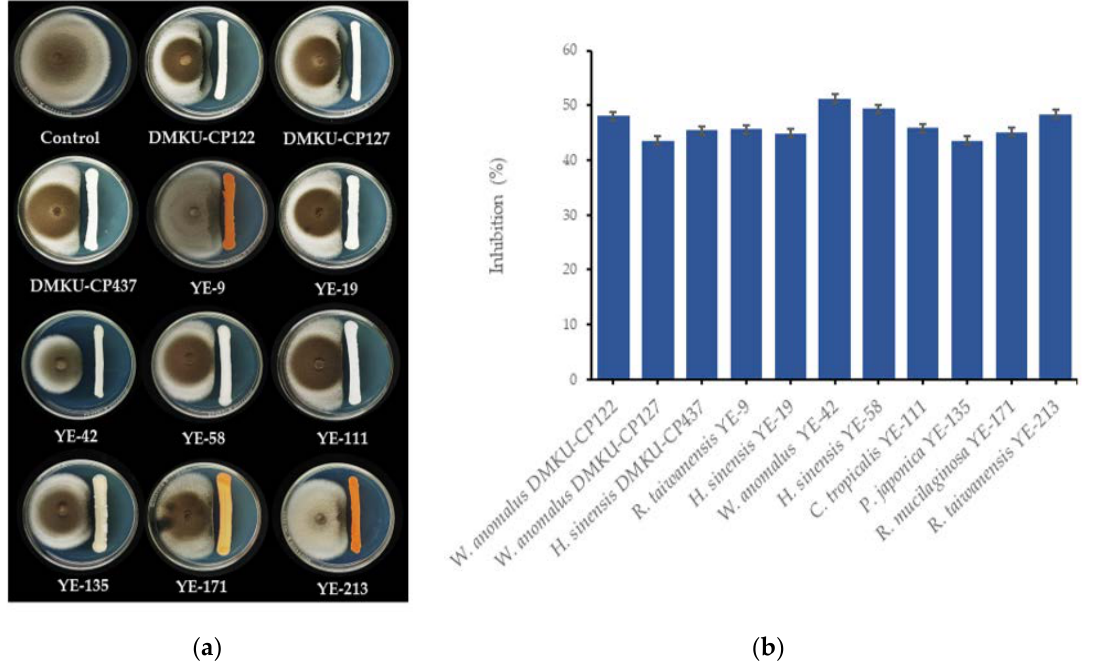
Figure 1. ( a ) Growth on potato dextrose agar (PDA) at 25 °C for seven days of Curvularia lunata DOAC 2313 alone, and dual cultured with Wickerhamomyces anomalus DMKU-CP122, W. anomalus DMKU-CP127, Hannaella sinensis DMKU-CP437, Rhodotorula taiwanensis YE-9, H. sinensis YE-19, W. anomalus YE-42, H. sinensis YE-58, Candida tropicalis YE-111, Papiliotrema japonica YE-135, Rhodotorula mucilaginosa YE-171, or R. taiwanensis YE-213; and ( b ) inhibition of growth of C. lunata DOAC 2313 by 11 antagonistic yeast strains determined by dual cultivation on PDA at 25 °C for seven days.